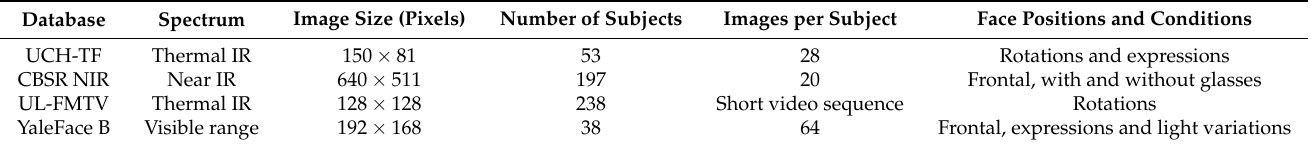
Table 3. Databases used to test the performance of the proposed